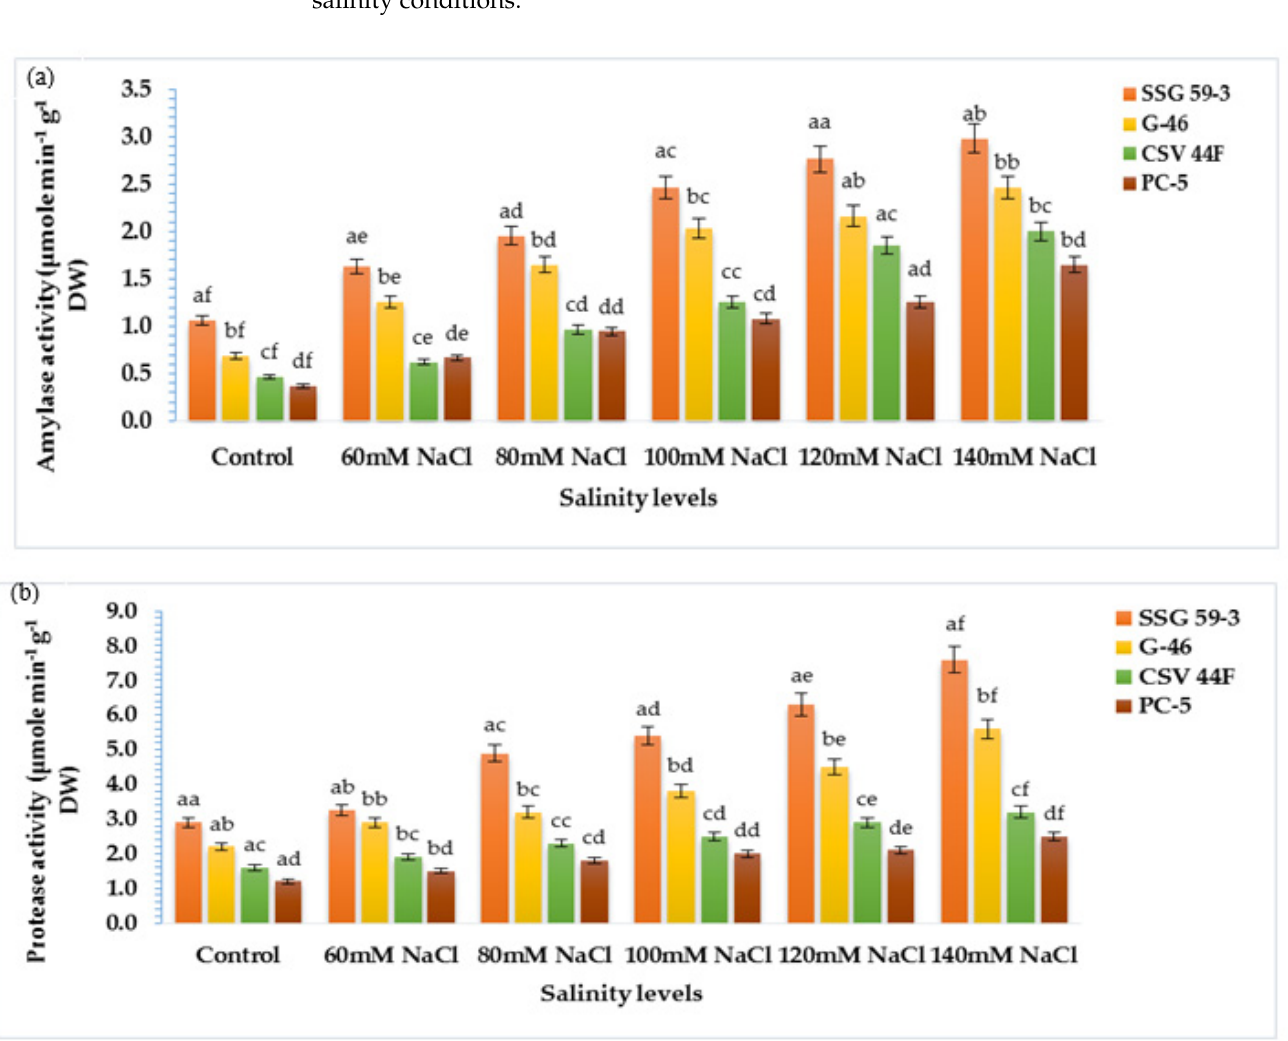
Figure 6. Effect of salinity on ( a ) α -amylase and ( b ) protease activity in germinating sorghum seedlings. Each value is the mean of triplicate. a–f Values with different superscripts in the same row are significantly different at p < 0.05.